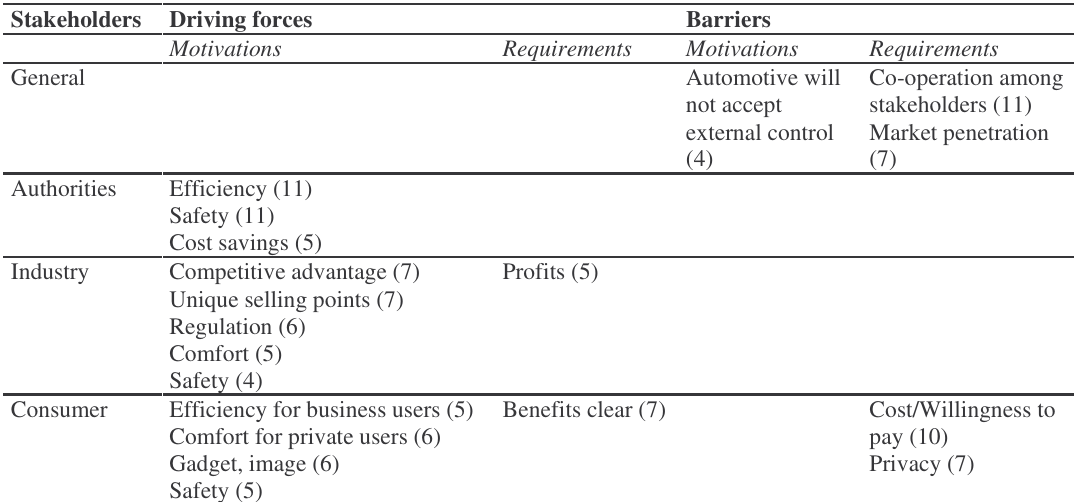
Table 2. Overview of the most important driving forces and